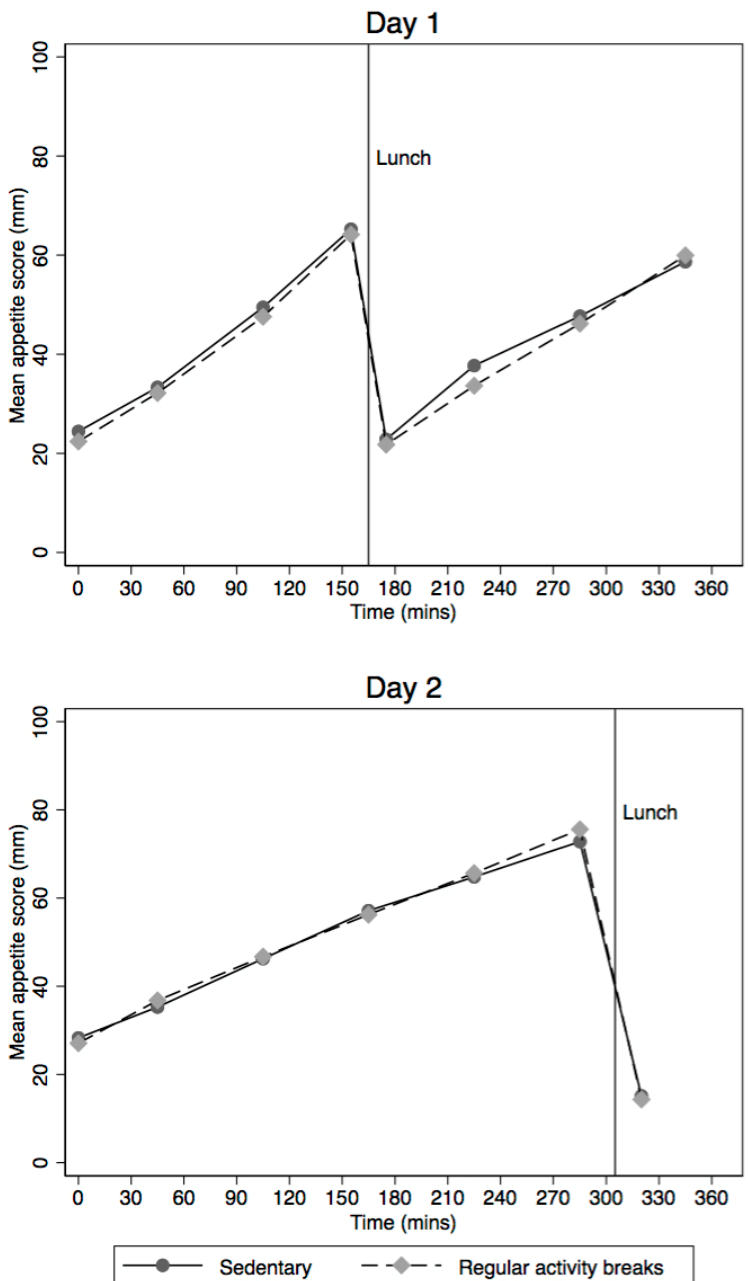
Figure 3. Average appetite scores for Days 1 and 2 of each intervention. The appetite score before the ad libitum lunch significantly predicted the amount (in grams) consumed ( β = − 2.4 mm; 95% CI: 0.8 mm, 3.9 mm, p = 0.003). The mean appetite score before the ad libitum lunch was 74.3 mm (95% CI: 71.9, 76.8), and the mean appetite score following the ad libitum lunch was 15.1 mm (95% CI: 12.9, 17.2), in which 0 mm was the lowest score possible and 100 mm was the highest. The mean change in appetite score (adjusted for period, order, and intervention) was − 59.3 mm (95% CI: − 62.3, − 56.4), p <